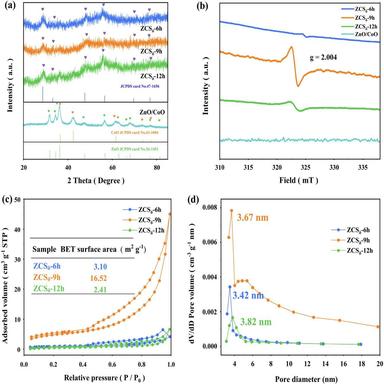
(a) XRD patterns of ZCSd-6h, ZCSd-9h, ZCSd-12h and ZnO/CoO; (b) EPR spectra of ZCSd materials; Nitrogen adsorption/desorption isotherms (c) and BJH mesopore distribution (d) for the ZCSd-6h, ZCSd-9h and ZCSd-12h samples.